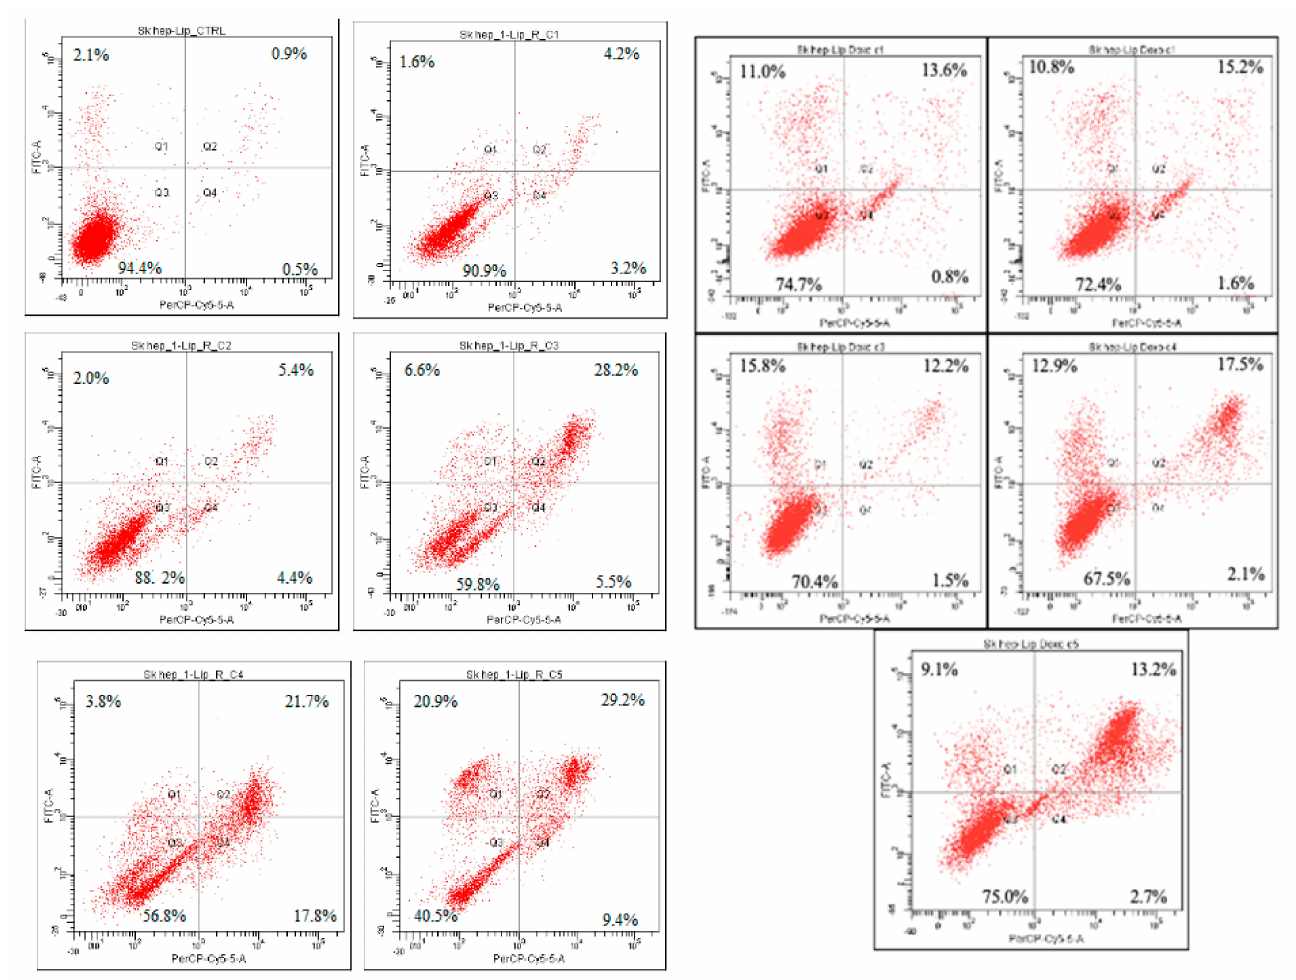
Figure 4. Apoptosis evaluation in SK-Hep-1 (HTB-52 ™ ) (10,000 events) after treatment with L-R and L-DOX. After 24 h of treatment, the cells were stained with Annexin V-FITC and Ethidium Homodimer III (EthD-III) and were evaluated using a BD FACS Canto II flow cytometer (Becton Dickinson, USA) using the BD FACSDiva 6.1.2 software. The results are shown in dot plots divided into 4 quadrants: Q3—viable cells, (Annexin V-FITC ( − ), EthD-III ( − )), Q1—early apoptotic